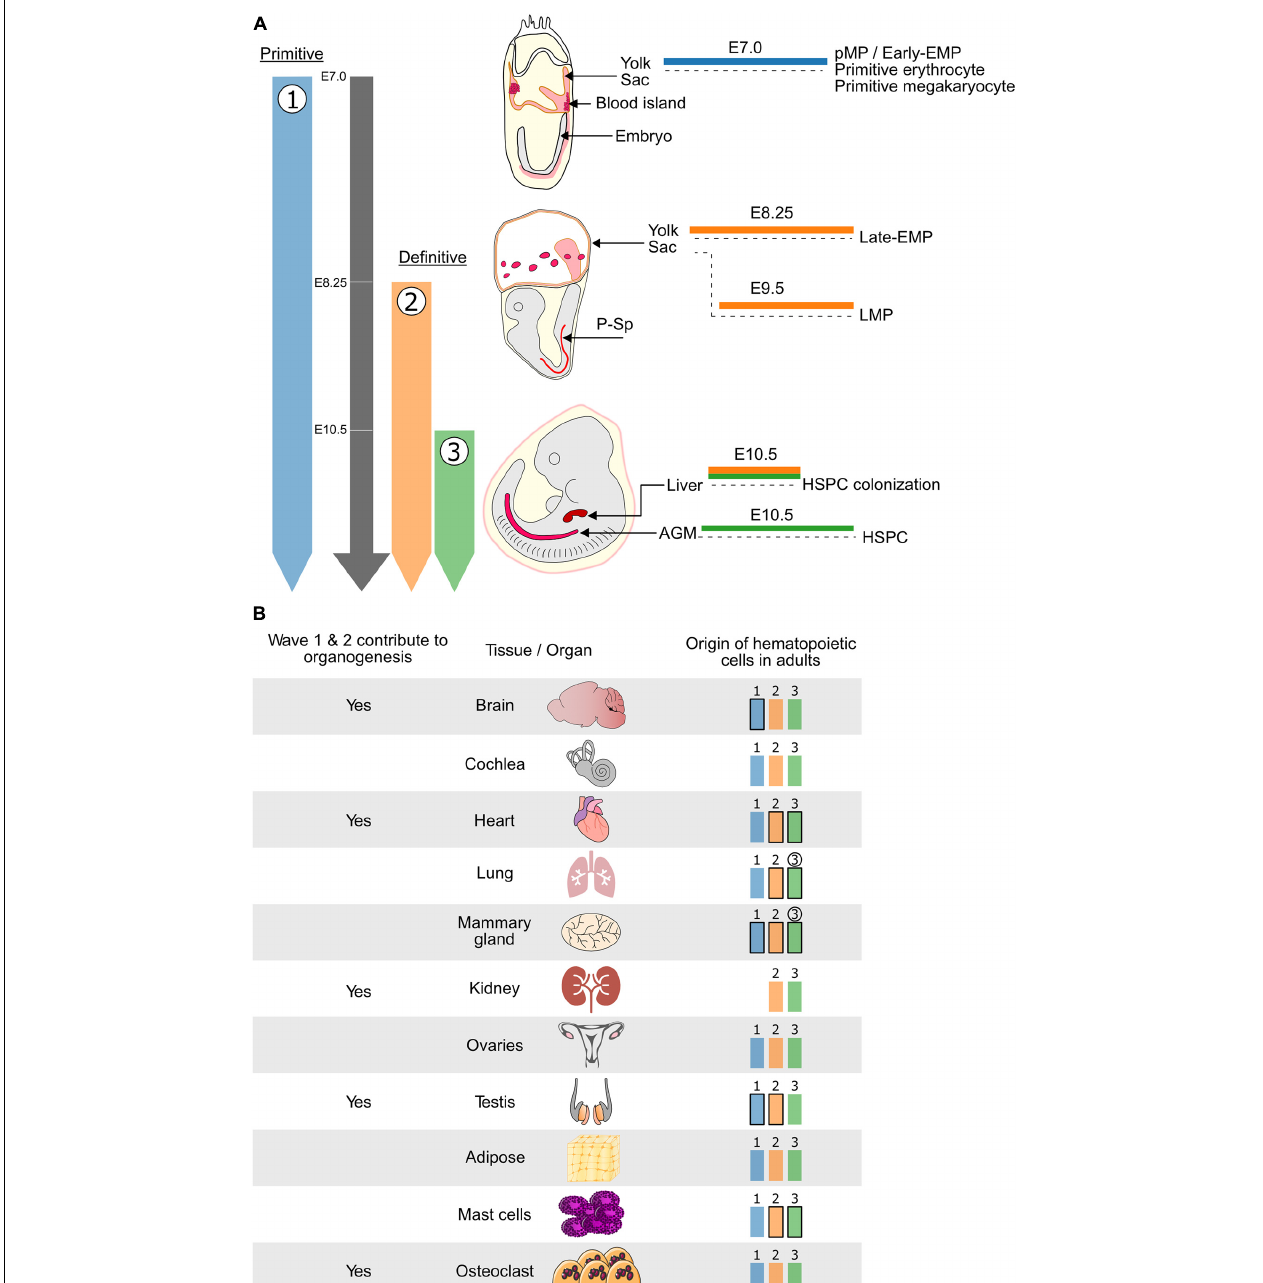
FIGURE 1 | The hematopoietic system is established in developmental waves that differentially contribute to embryonic organogenesis and the adult hematopoietic system. (A) Schematic representing the timing and embryonic sites of hematopoietic activity during mouse development. The three waves of hematopoiesis are represented in Blue (wave 1: primitive erythrocytes, megakaryocytes, macrophages and Early EMP), Orange (wave 2: Late EMP and LMP) and Green (wave 3: HSPC). Wave 1 is known as the primitive wave while waves 2 and 3 constitute the definitive waves of hematopoiesis. Waves 1 and 2 which do not generate HSCs originate in the Yolk Sac while wave 3, which generates the HSPCs, is initiated in the AGM region of the embryo proper. Cells from both waves 2 and 3 can colonize the fetal liver where they can mature and expand before moving to their final destination. (B) (Left) HSC-independent macrophages which originate from the first two hematopoietic waves have been shown to play important roles during embryonic development of several tissues and organs. (Right) In addition to the wave 3 (Green) HSC-derived hematopoietic cells, the HSC-independent hematopoietic cells generated during wave 1 (Blue) and 2 (Orange) persist, to varying degrees, in adult tissues and organs. Waves that contribute most of the hematopoietic cells are depicted in bold and waves for which the contribution increases overtime are circled. Blue: hematopoietic wave 1 (primitive), Orange: hematopoietic wave 2 (Late-EMP/LMP), Green: hematopoietic wave 3 (HSC). E, embryonic day; M ϕ , macrophage; HSC, hematopoietic stem cell; EMP, erythroid–myeloid progenitor; LMP, lymphoid–myeloid progenitor; HSPC, hematopoietic stem and progenitor cell; P-Sp, para-aortic splanchnopleura; AGM, aorta-gonad-mesonephros.